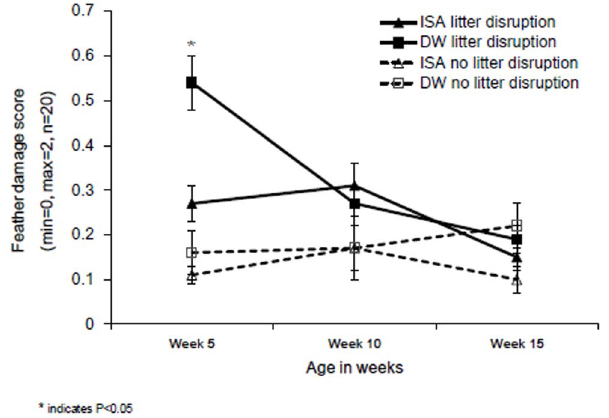
Figure 5. Feather damage score of Dekalb White (DW) and ISA brown (ISA) at 5, 10 and 15 weeks of age in relation to litter disruption.